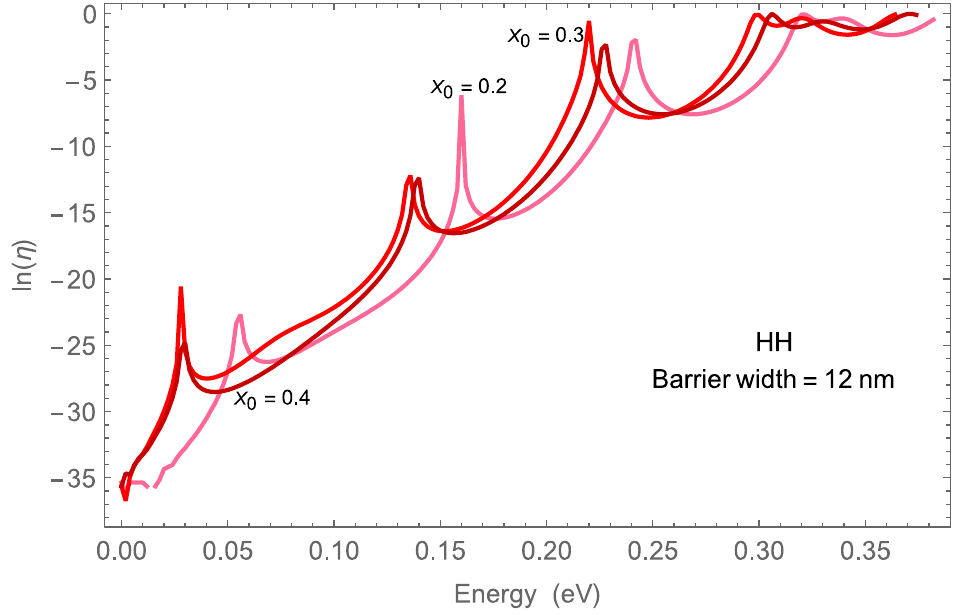
Figure 9. Logarithm of the transmission coefficient for HH as a function of energy for the double- barrier In x Ga 1 − x N/GaN parabolic quantum well structure with various x 0 at an applied bias of 0.8 V, and barrier width 12